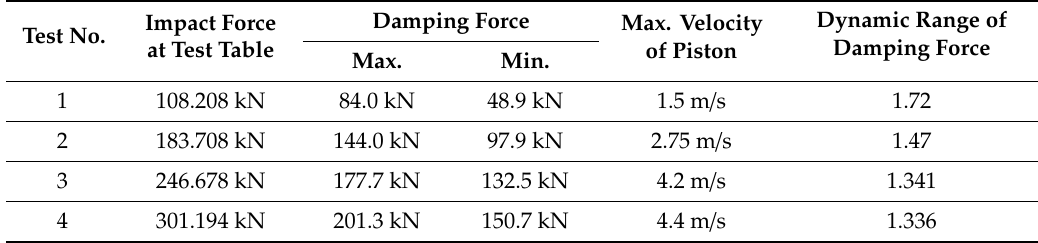
Figure 9. MR damper experimental results at an impact velocity of 9.12 m/s (Test 4): ( a ) Damping force; ( b ) Piston velocity; ( c ) force-velocity (F-V) diagram of MR damper. Table 1. Measured experimental